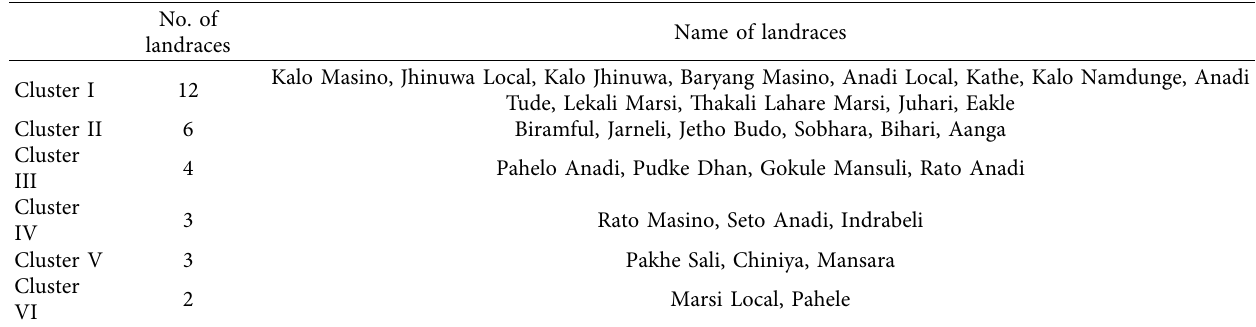
Figure 5: The biplot of 30 rice landraces for PC3 and PC4. The arrows show the contribution (magnitude and direction) of the trait in PC3 and PC4. QI is the quality of representation of individuals, and QV is the quality of representation of variables. (TG: total grain, FGP: filled grain percentage, PL: panicle length, GL: grain length, GW: grain width, KL: kernel length, KW: kernel width, FLL: flag leaf length, FLB: flag leaf breadth, ET: effective tiller, PH: plant height, TGW: thousand-grain weight, GY: grain yield). Table 3: Distribution of 30 landraces from Lamjung and Tanahun districts into six clusters.